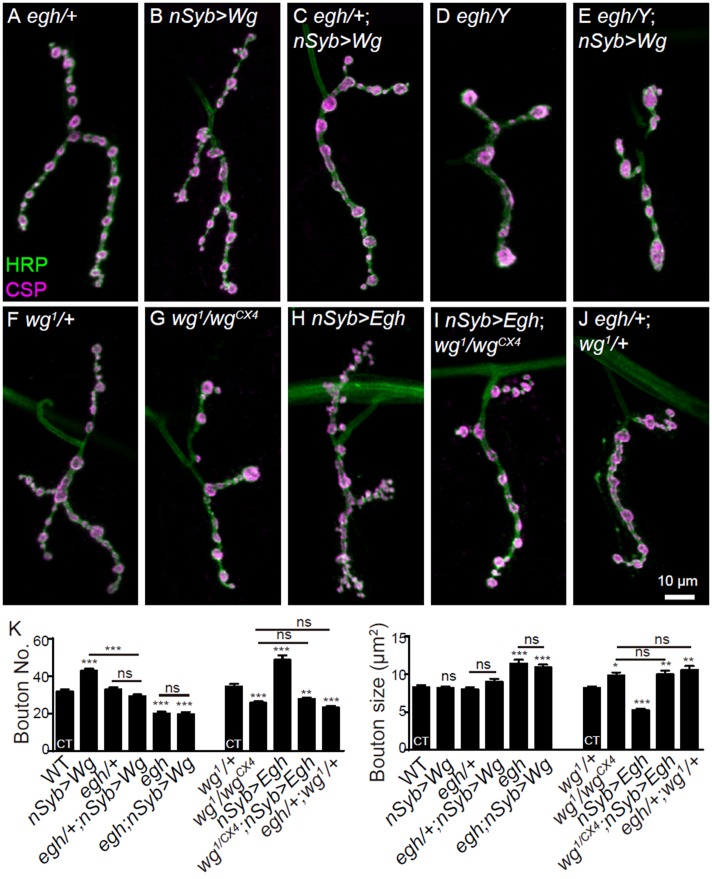
MacCer is required for the NMJ growth-promoting effect of Wg signaling.(A–J) Representative images of NMJ4 co-stained with anti-HRP (green) and anti-CSP (magenta) in egh62d18/+ (control, (A), UAS-Wg-HA/+; nSyb-Gal4/+ (B), egh62d18/+; UAS-Wg-HA/+; nSyb-Gal4/+ (C), egh62d18 (D), egh62d18; UAS-Wg-HA/+; nSyb-Gal4/+ (E), wg1/+ (F), wg1/wgCX4 (G), nSyb-Gal4/UAS-Egh (H), wgCX4,UAS-Egh/wg1; nSyb-Gal4/+ (I), and egh62d18/+; wg1/+ (J).Scale bar: 10 μm. (K) Quantifications of bouton number and bouton size of NMJs in different genotypes. ‘CT’ denotes corresponding control in each multiple comparison. n ≥ 12 larvae; ns, no significance, *p<0.05; **p<0.01; ***p<0.001 by one-way ANOVA with Tukey post hoc tests, error bars: s.e.m.10.7554/eLife.38183.016Figure 5—source data 1.Numerical data for the statistical graphs.